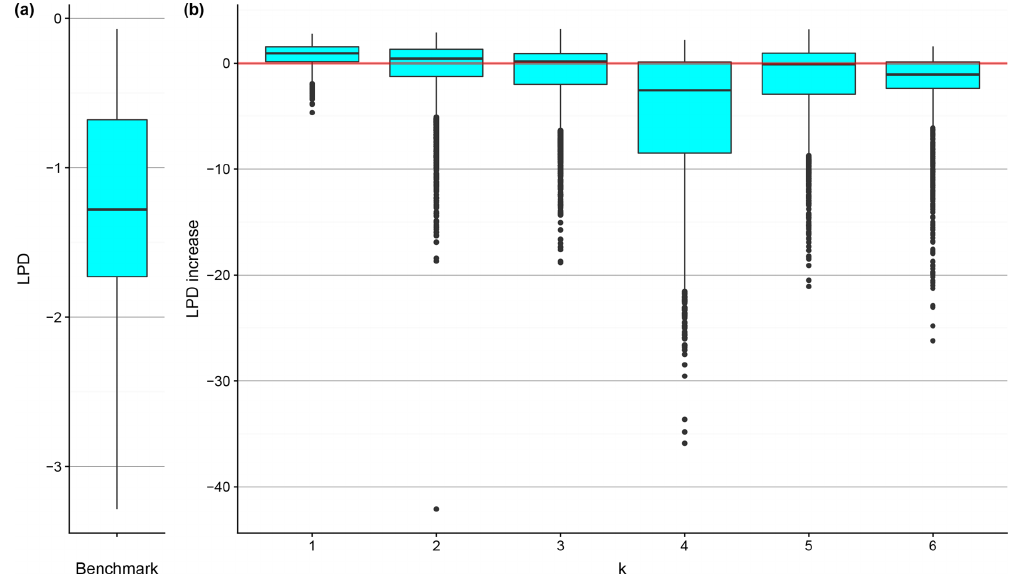
Figure 7. The box plot of the LPD of the benchmark model at the testing watersheds (a) and the box plots of the LPD increase introduced by applying the BART models at the testing watersheds (b) . The red line indicates zero LPD increase, used for comparison.